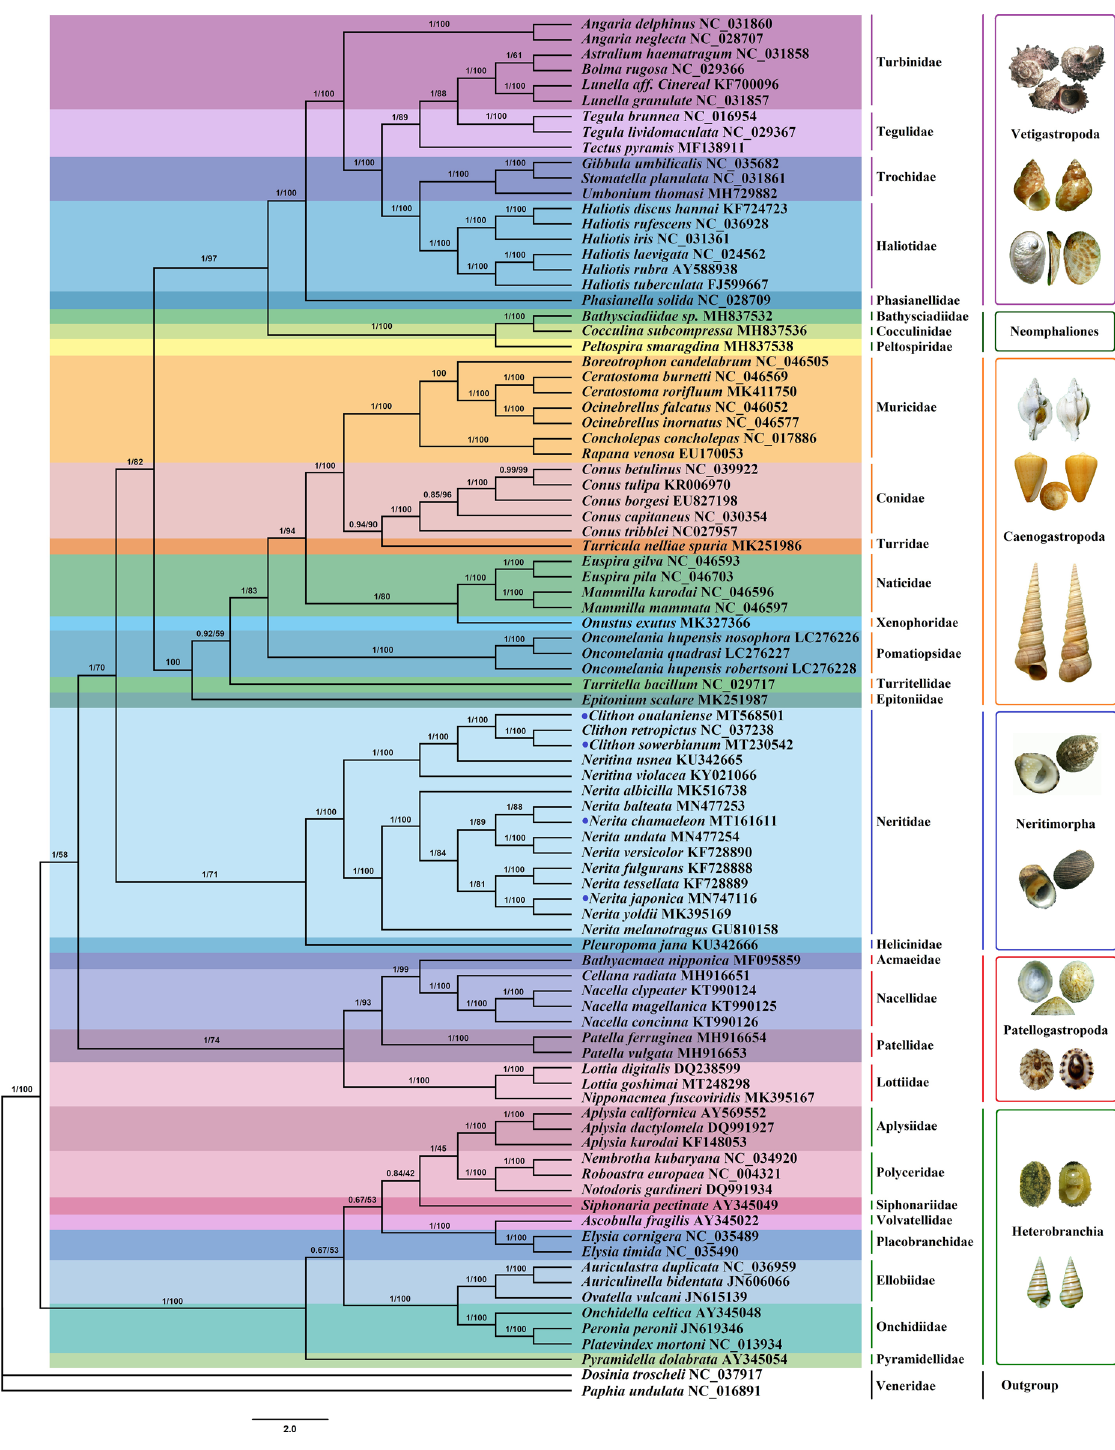
Figure 6. Phylogenetic tree inferred using Bayesian inference (BI) and maximum likelihood (ML) methods based on concatenated sequences of 13 PCGs from 88 gastropod mitogenomes. The sequences of two Veneridae species were chosen as the outgroups. The blue dots indicate the four Neritidae species sequenced in this study. The number at each node is the bootstrap